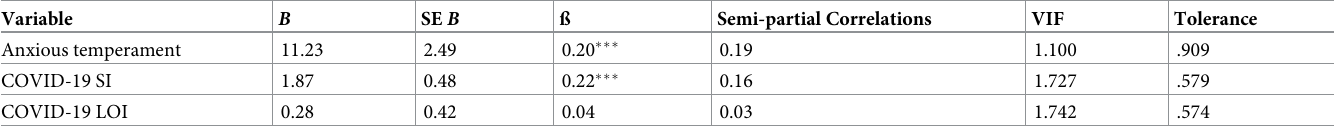
Table 4. Linear regression analysis of anxious temperament, self-infection and COVID-19-related fear of loved ones’ infection as predictors of cyberchondria in the whole sample (N = 499) with variance inflation factor (VIF). Variable